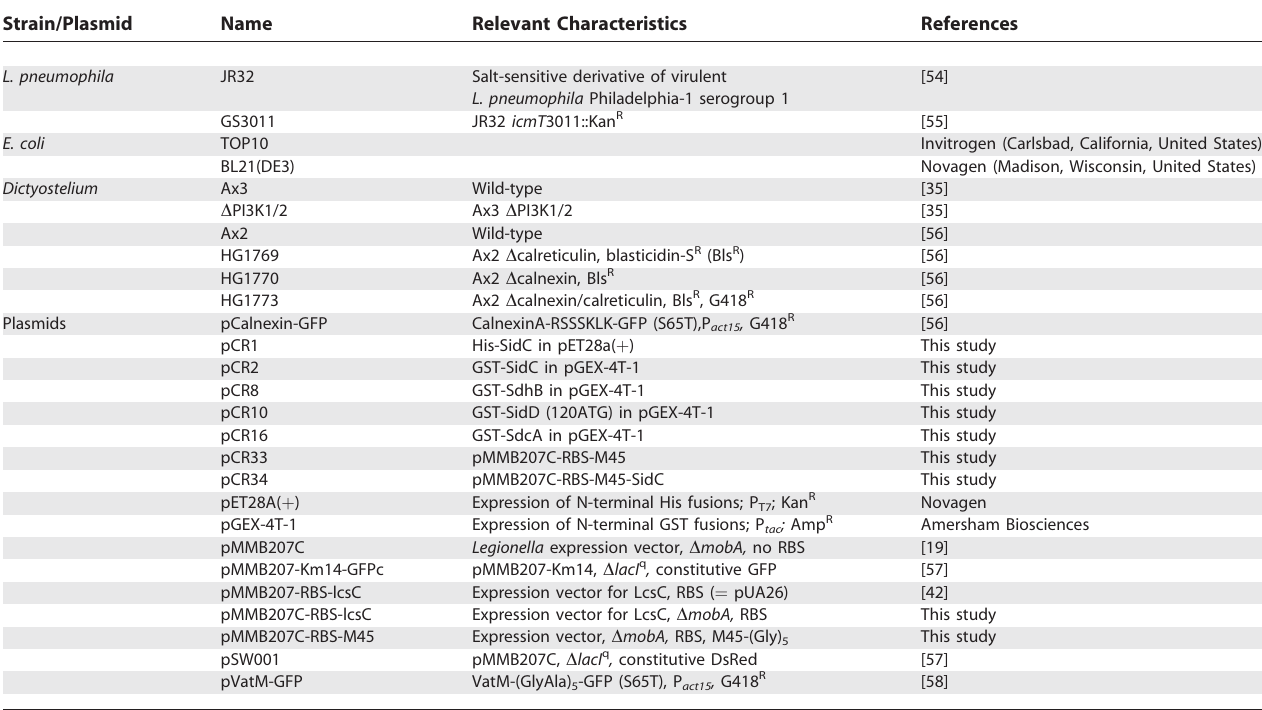
Table 1. Strains and